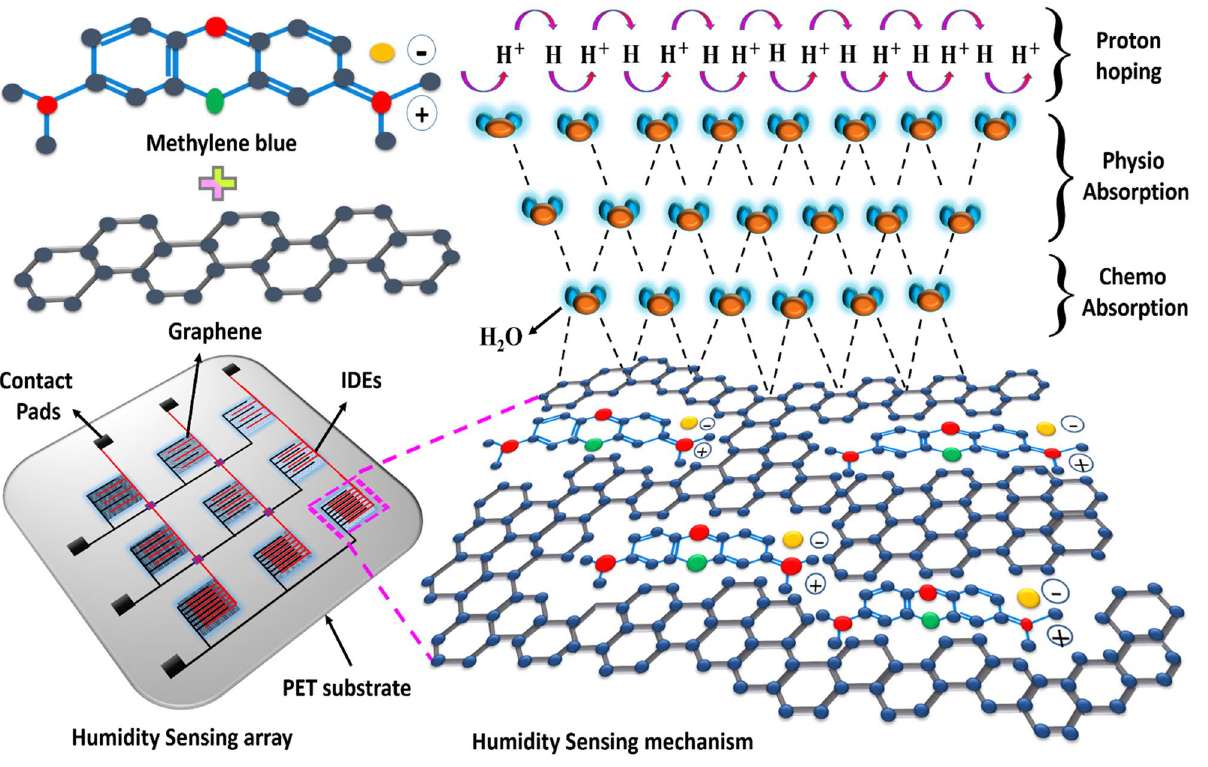
Figure 1. Humidity sensing array and sensing